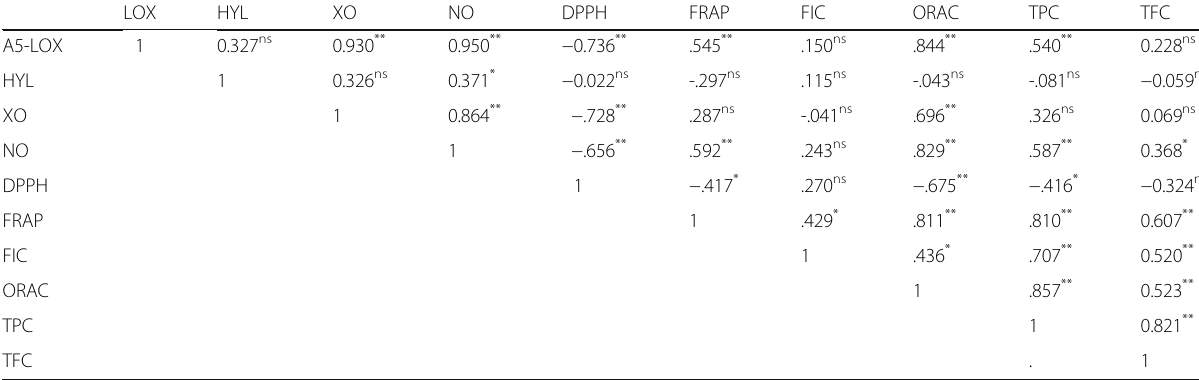
Table 6 Pearson ’ s correlation coefficients of in-vitro anti-inflammatory activities, antioxidant activities, total phenolic and total flavonoids content of